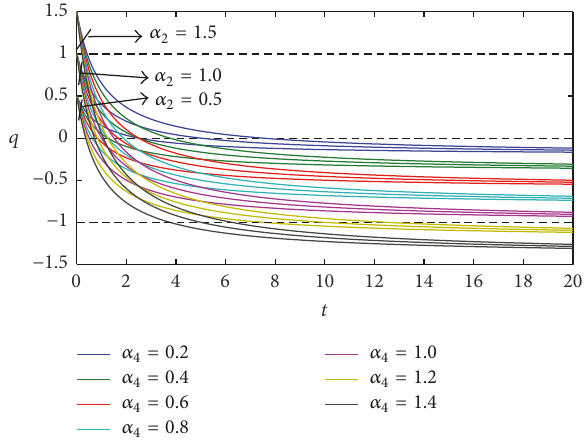
Figure 1: Variation of deceleration parameter against time for fixed 𝛼 𝛼 2 and different 4